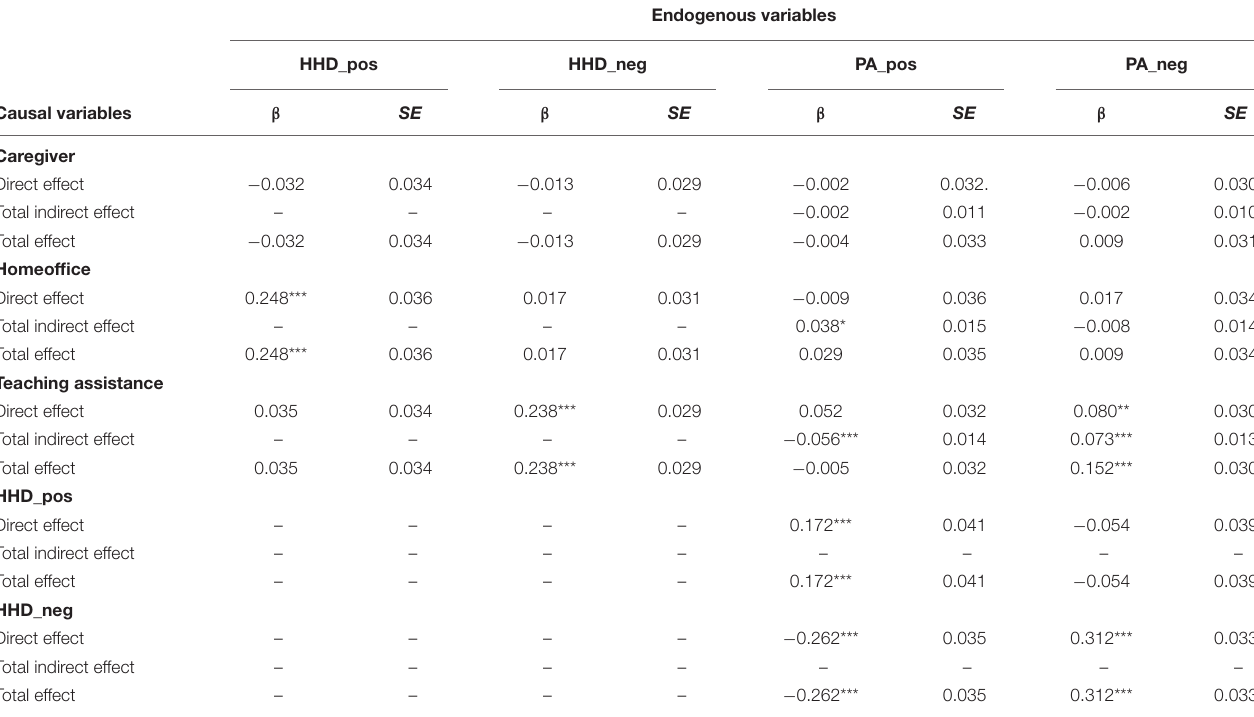
FIGURE 2 | Final (structural) model for partially latent structural regression using FIML with standardized coefficients. Non-significant paths are in dotted lines, whereas significant ones are in solid lines. TABLE 6 | Effects breakdown between exogenous and endogenous variables of the final model showing mediated